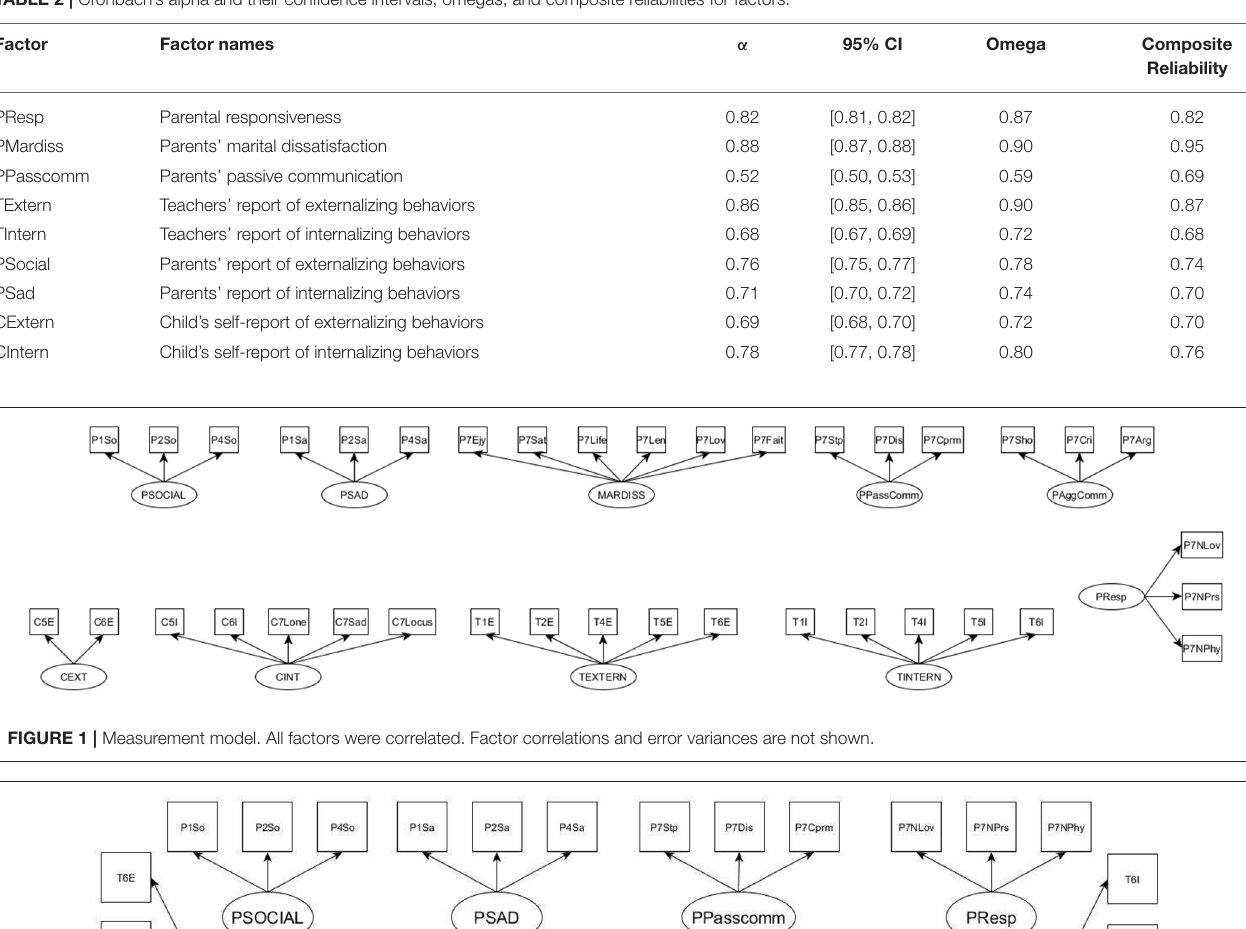
TABLE 2 | Cronbach’s alpha and their confidence intervals, omegas, and composite reliabilities for factors.